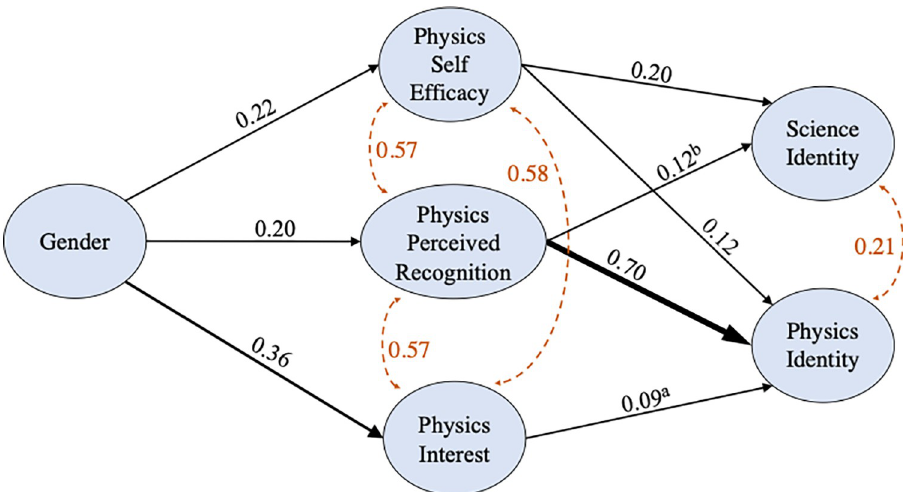
Fig 2. Result of the path analysis part of the SEM with mediation between gender and science/physics identity through physics perceived recognition (P.R.), self-efficacy, and interest. The line thickness qualitatively denotes the relative magnitude of the standardized regression coefficients β shown. The dashed lines indicate covariance. All p- values for β are indicated by no superscript for p < 0.001, “a” for p = 0.004, “b” and for p = 0.010.